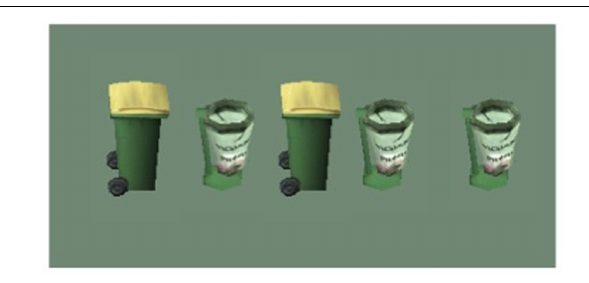
FIGURE 2 | Example of a spatial arrangement of yellow and green garbage containers, all arranged along a straight line.